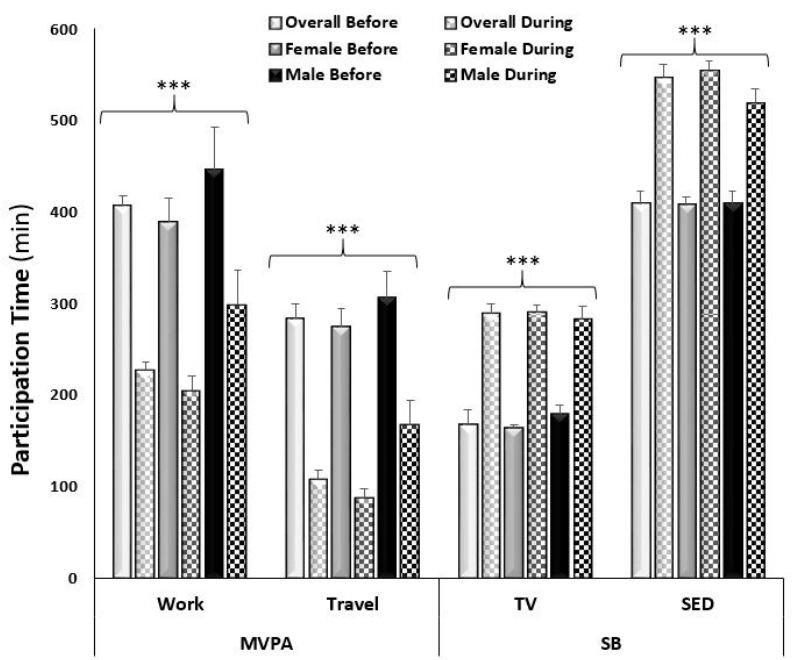
Figure 1. Average weekly self-reported time (minutes) spent in moderate-to-vigorous physical activity (MVPA) related to work and travel and time spent in sedentary behaviors (watching TV and sitting). *** Significant difference by time point overall and a significant sex by time point interaction (adj. p < 0.0001 ).